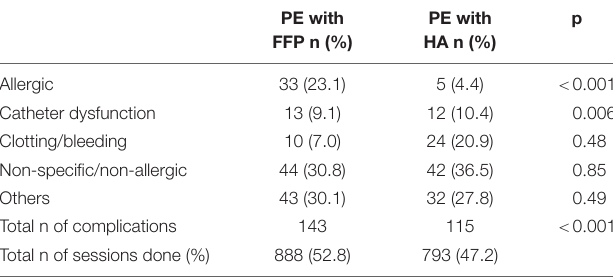
TABLE 5 | Complications according to substitute.